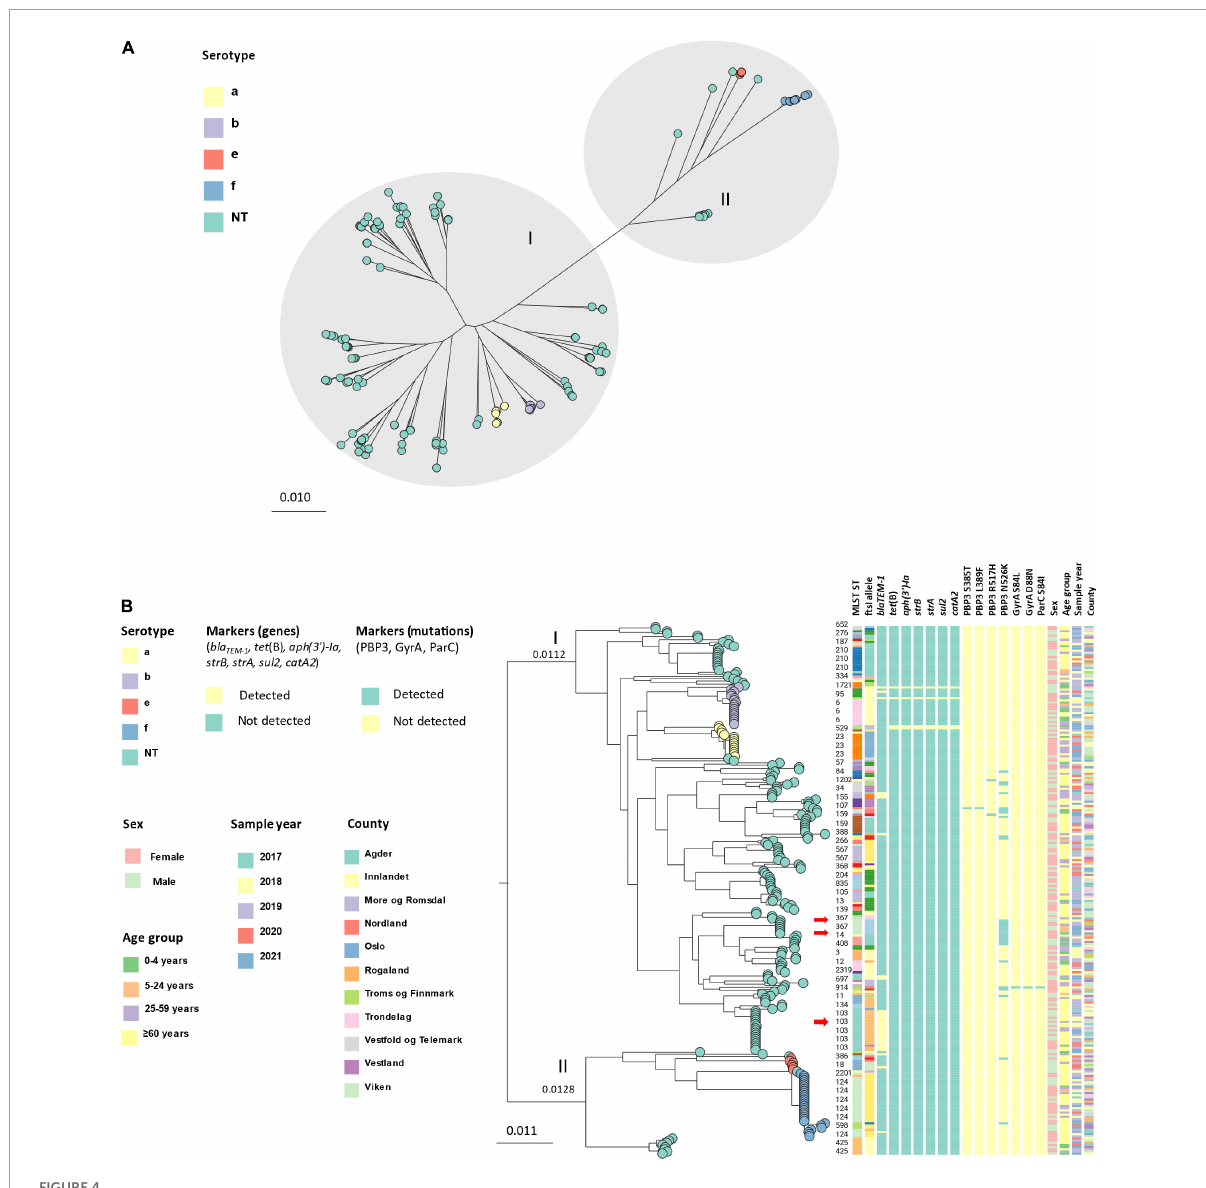
FIGURE4 (A) Unrooted approximately-maximum-likelihood phylogenetic tree based on the core genome (core genes: 1158) of 245 invasive Haemophilus influenzae isolates from Norway 2017–2021. The isolates cluster in two main groups (division I and II, gray shading) and by serotype (leaf node color). (B) Midpoint-rooted approximately-maximum-likelihood phylogenetic tree based on core genome (core genes: 1158) annotated with division, serotype (leaf node color), ST, ftsI allele, markers of antibiotic resistance (genes and mutations), sex, age, sample year and county. The red arrows show clusters containing beta-lactam resistance markers (clusters 2, 8, and 11; Table 1